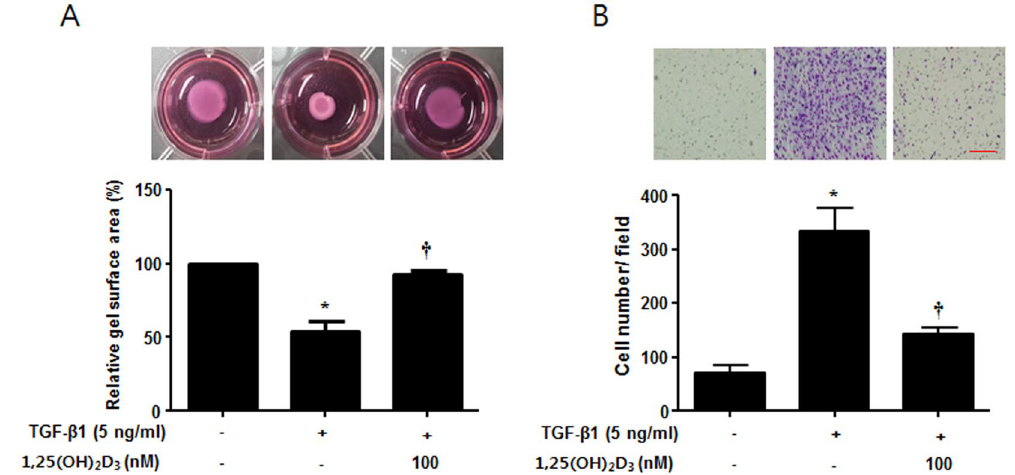
Figure 5. 1,25(OH) 2 D 3 decreases TGF- β 1-induced collagen gel contraction and cell migration in nasal polyp- derived fibroblasts. Nasal polyp-derived fibroblasts were treated with TGF- β 1 and/or 1,25(OH) 2 D 3 for 72